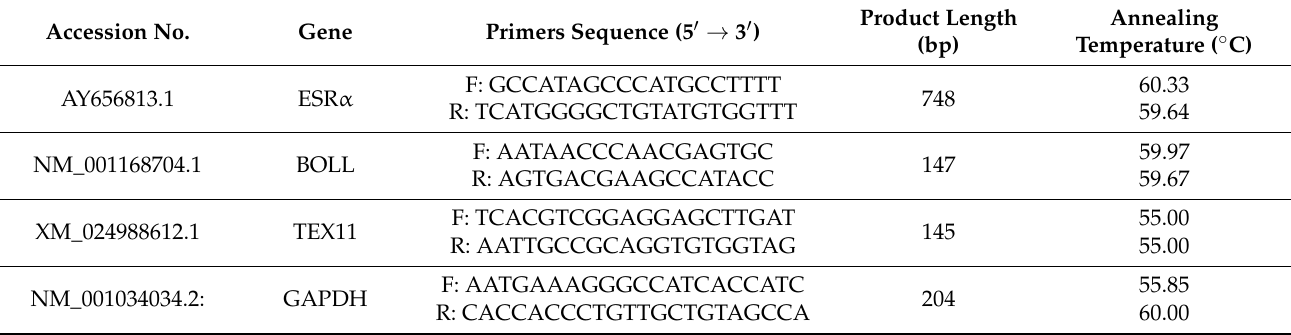
Table 2. qPCR primers designed based on bovine genomic